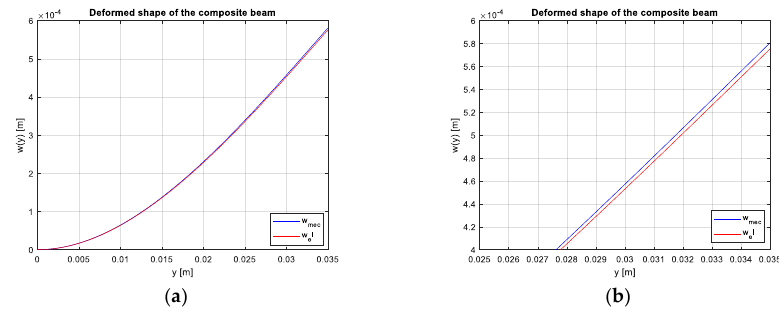
Figure 3. ( a ) Deformed shape of the PZT – Steel composite beam; ( b ) Close up view.